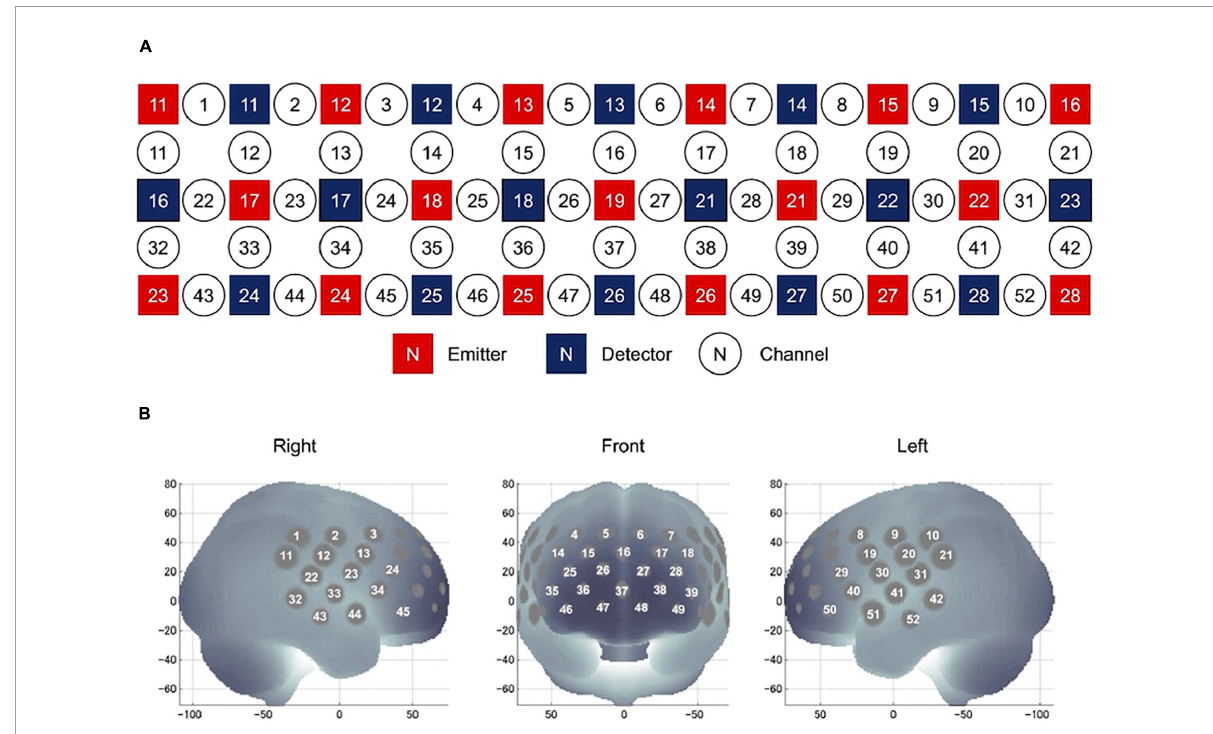
FIGURE3 Location of NIRS channels. (A) Arrangement of the 17 emitters and 16 detectors and definition of the channels. (B) The anatomical site corresponding to each